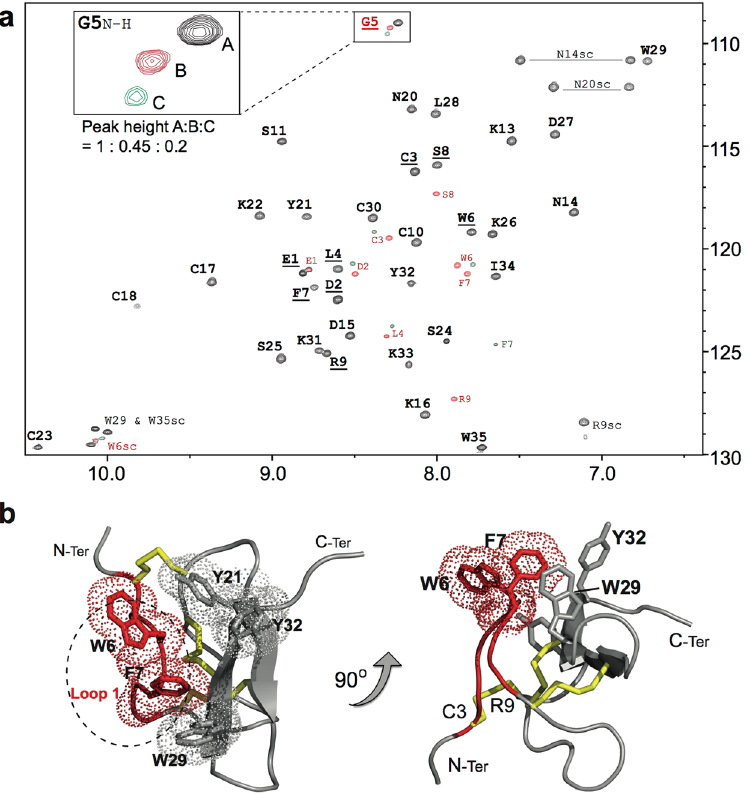
Figure 3. Pre1a shows conformational flexibility in aqueous conditions. ( a) 2D 1 H- 15 N-HSQC of recombinantly produced Pre1a. The chemical shifts of resonances for residues in loop 1 (D2–R9, underlined) show multiple peaks indicating the presence of three conformations of the peptide (A = Major, B = middle, C = minor, highlighted for G5 in the inset). sc = side chain NH resonances for N, R and W residues. ( b) Two views of a homology model of Pre1a (based on the NMR structure of HwTxIV, PDB: 2M4X) illustrating the relative positions of W6 and F7 at the tip of Loop 1 and W29, Y32 and Y21. Loop 1 residues (that show multiple peaks in the HSQC above) are in red, disulfide bonds are in yellow. The right panel highlights the position of W6 and F7 at the tip of Loop 1 and the positions of C3 and R9, which may act as a hinge region for movement of the